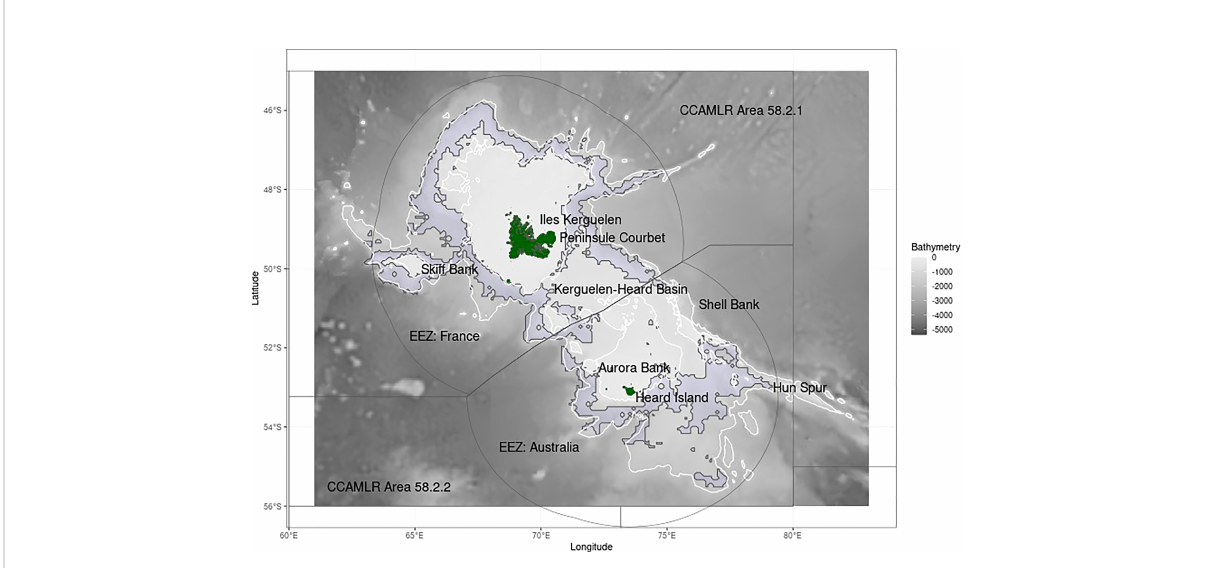
FIGURE 1 Map of the Kerguelen Plateau, indicating the approximate position of the fi shing grounds (blue shaded area after Peron et al. (2016)), and the major geographic features. Also shown are the; -2000m and -500m bathymetric contours (GEBCO 19), the boundaries of CCAMLR managements areas and the 200nm French and Australian Economic Exclusion Zones